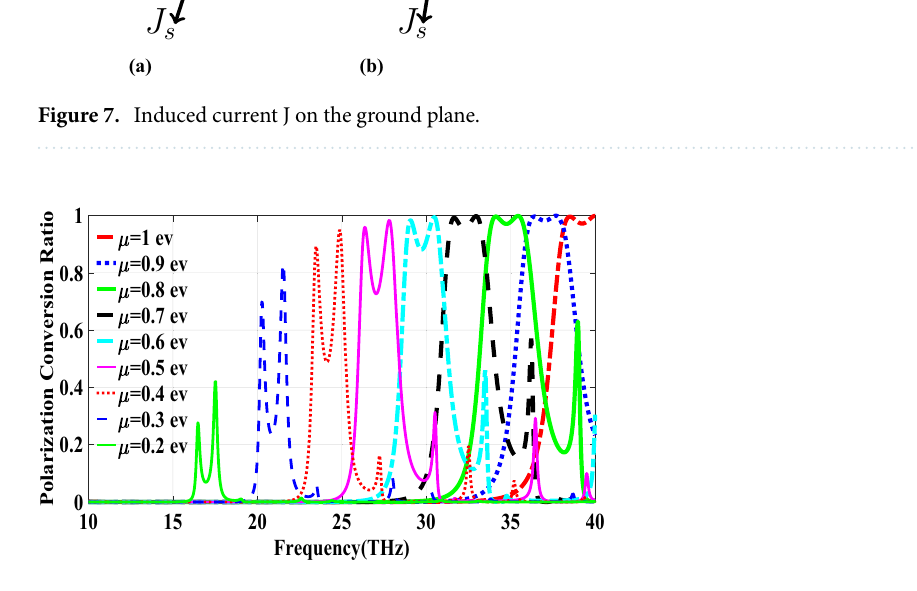
Figure 8. PCR of the first structure for different chemical potentials of